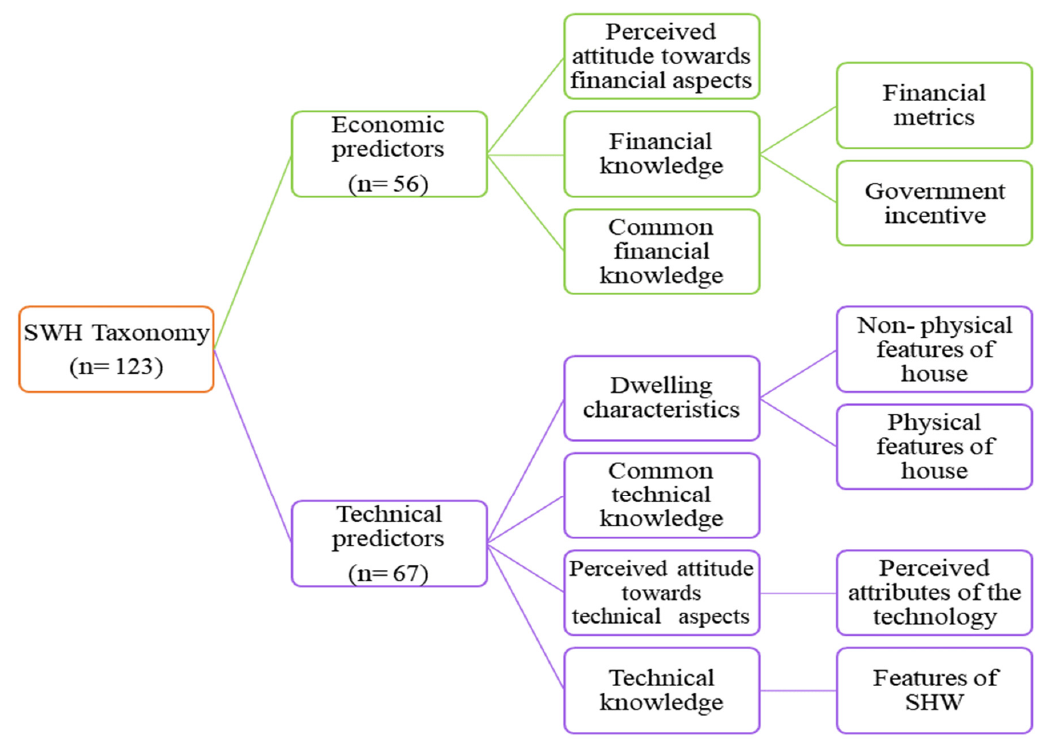
Energies 2021 , 14 , x FOR PEER REVIEW Figure 3. Taxonomy of solar adoption behaviour predictors by households in three layers (n = number of predictors). The green rectangle illustrates economic predictors, and the purple ones represent technical predictors.